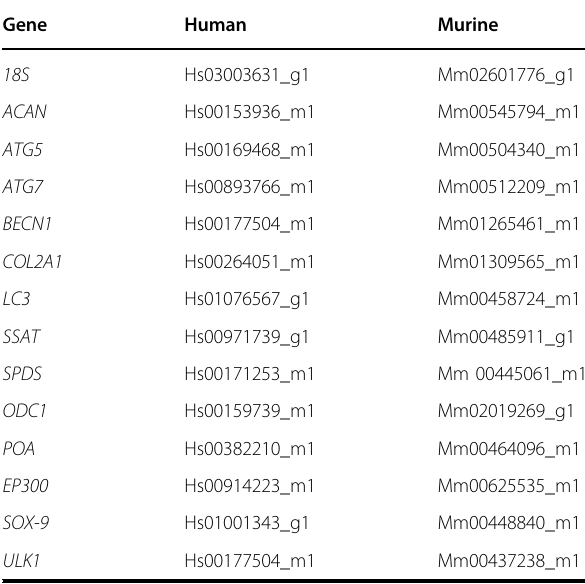
Table 1 Primers used in RT-qPCR